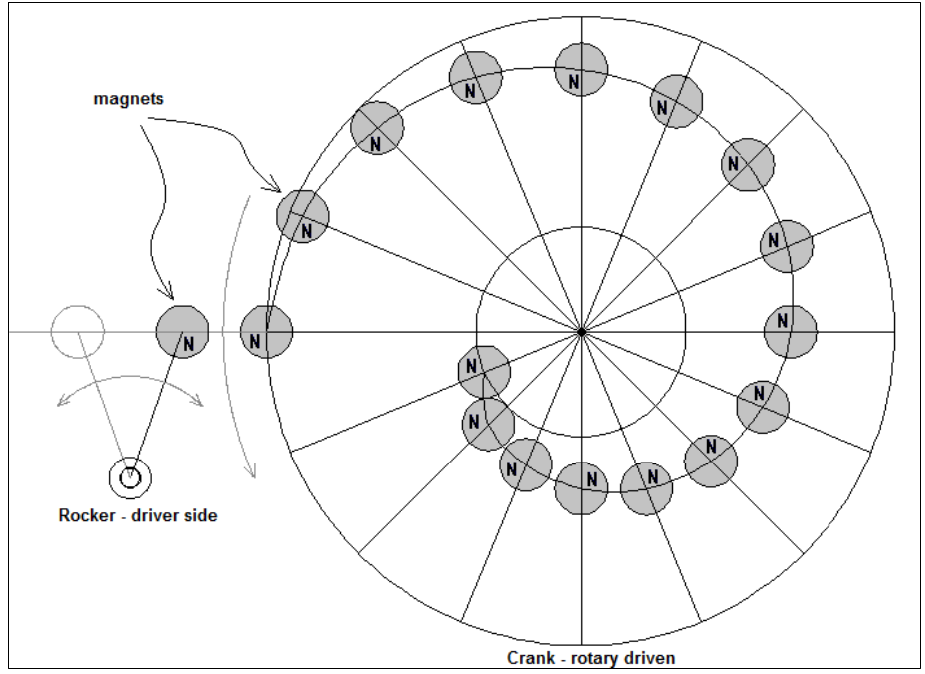
Figure 1. Scheme of proposed magnetic contactless crank-rocker